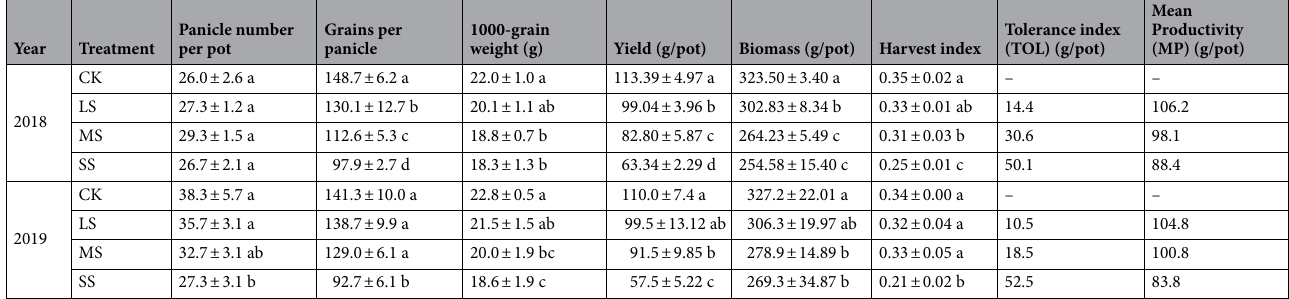
(Table 3). The naked oat TOL under LS, MS and SS was 14.4, 30.6 and 50.1 g/pot in 2018, while the TOL was lower under LS and MS in 2019 with values of 10.5 and 18.5 g/pot. The TOL was higher under SS in 2019 with a value of 52.5 g/pot (Table 3). The naked oat MP under LS, MS and SS in 2018 was 106.2, 98.1 and 88.4 g/pot, while the MP was lower in 2019 under LS and SS with values of 104.8 and 83.8, and the MP was higher in 2019 under MS with a value of 98.1 (Table 3).